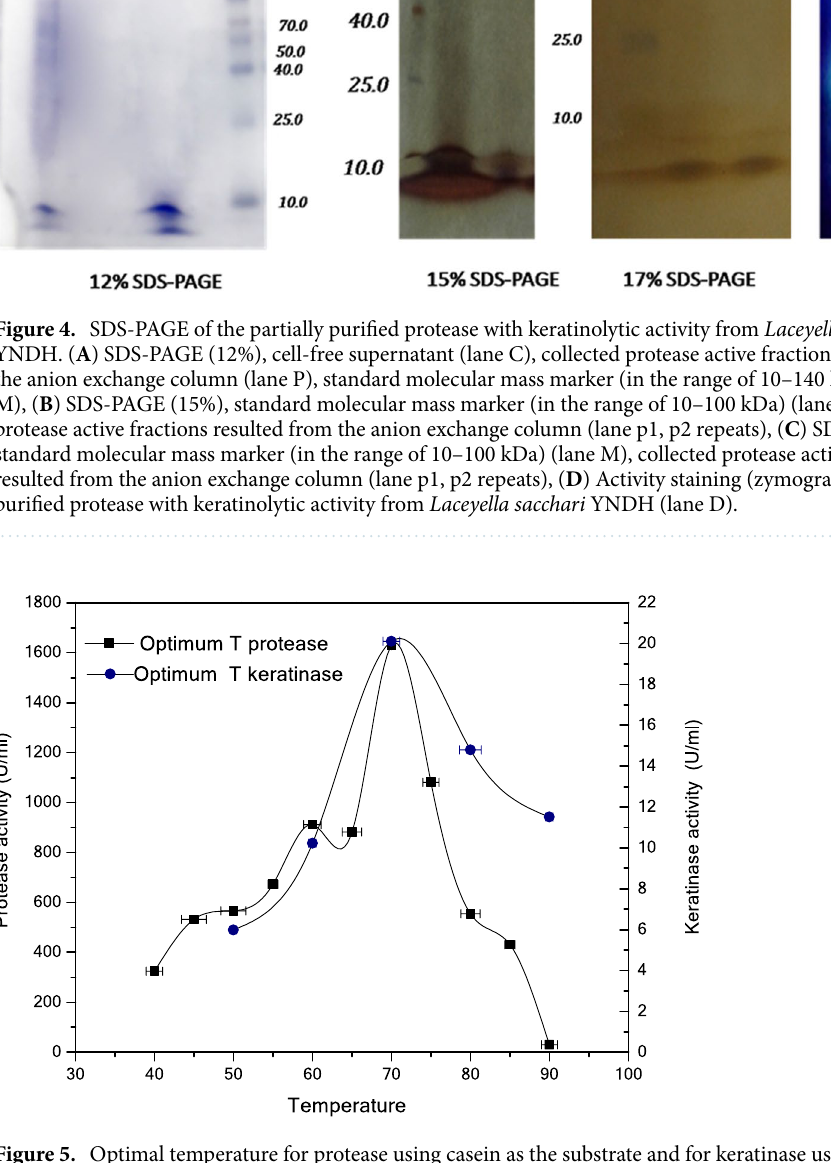
Figure 5. Optimal temperature for protease using casein as the substrate and for keratinase using keratin-azure as the